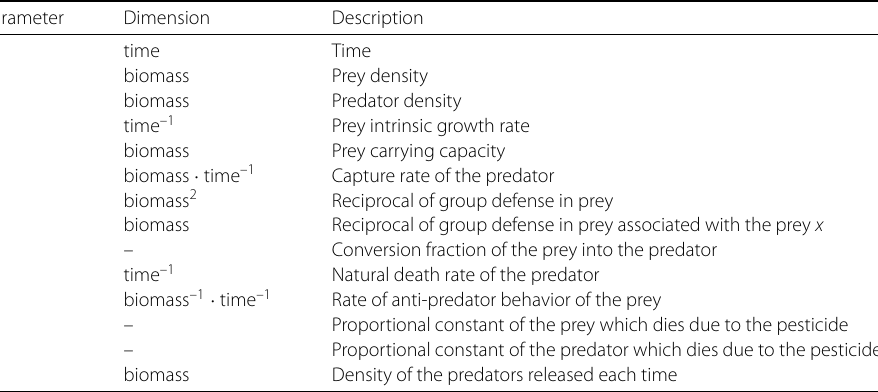
Table 1 Descriptive list of the variables and parameters appearing in system (7) Parameter Dimension